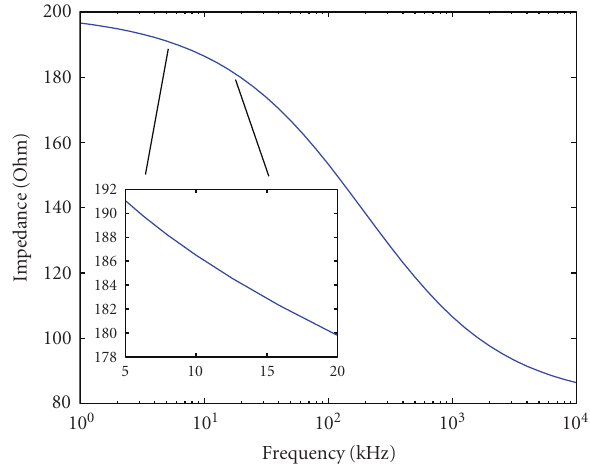
Figure 1: Typical example of a beta dispersion in a tissue. A specific band between 5kHz and 20 kHz is shown in more detail to demon- strate the nearly linear